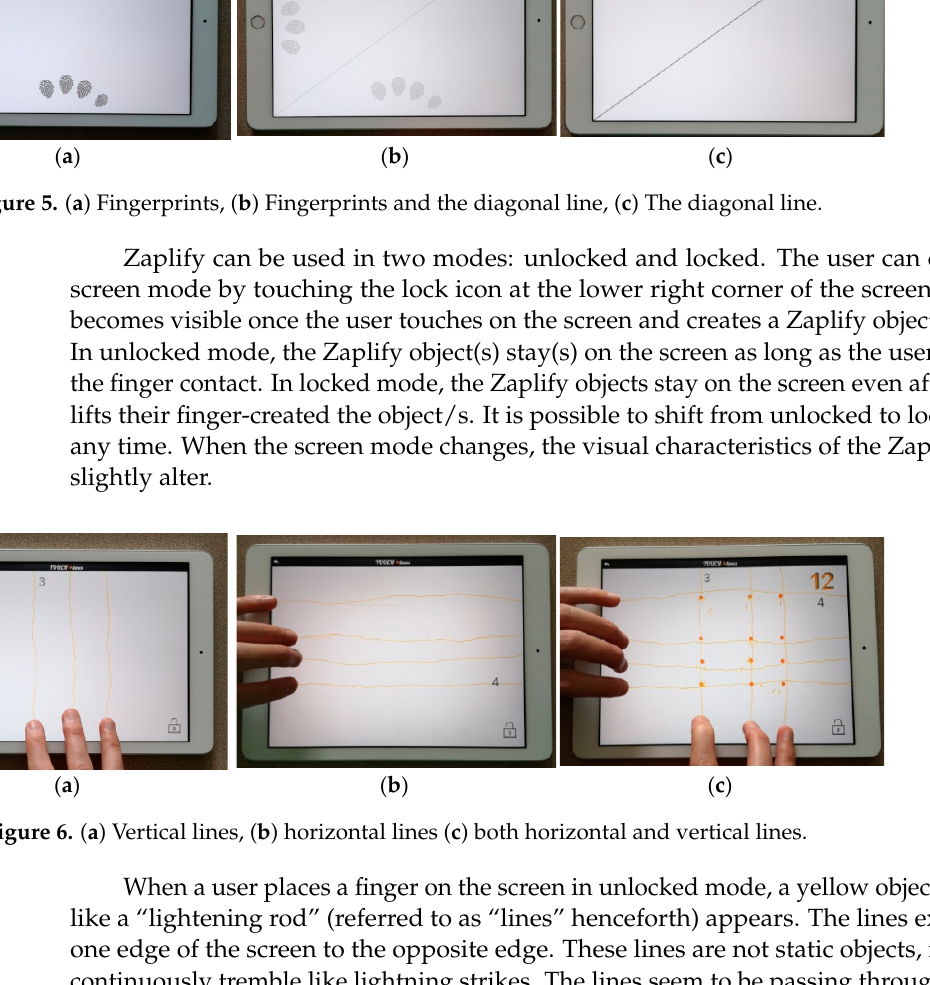
position of the